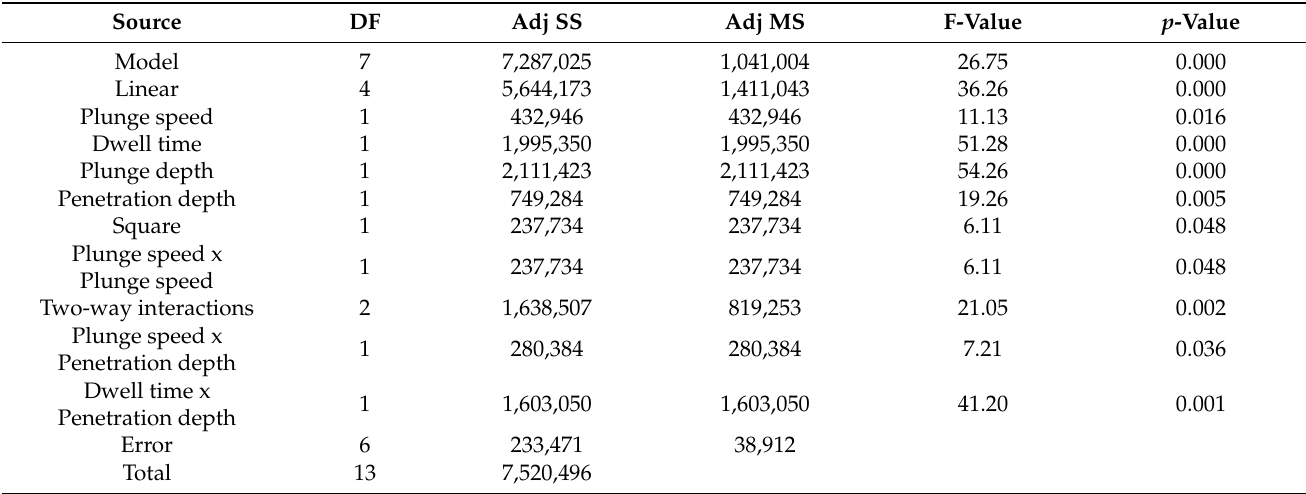
Table 5. Analysis of variance.